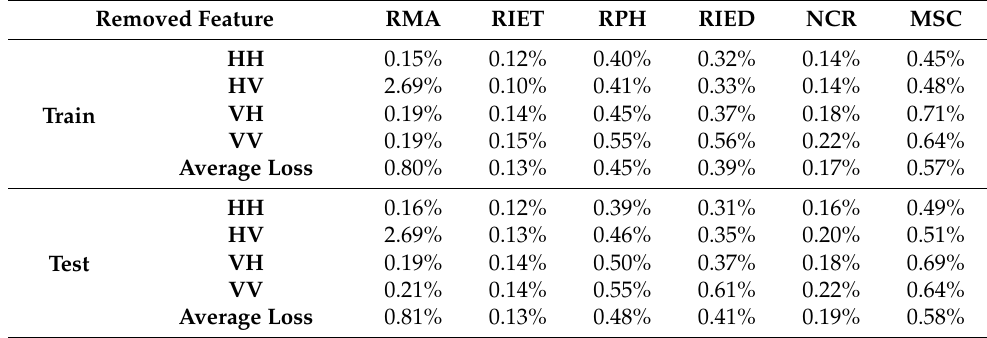
Table 12. Performance loss of removing different features.